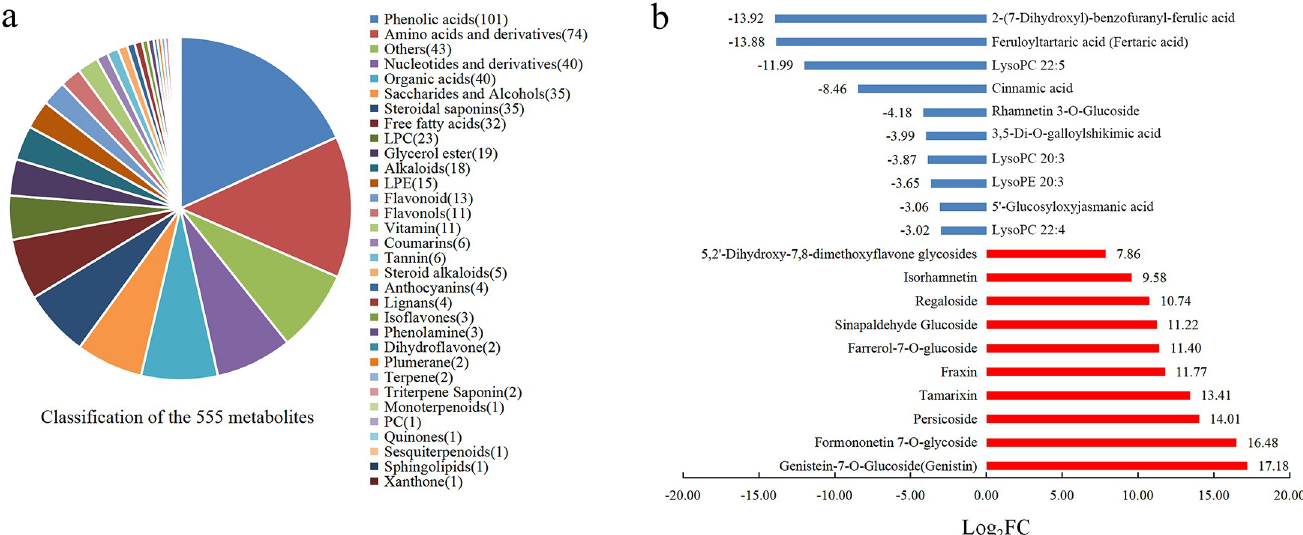
Fig 3. Metabolite analysis. a. Classification of metabolites. b. Significantly different metabolites (only the top 20 P -values are shown; blue bars denote down- regulated expression, and red bars denote up-regulated expression).